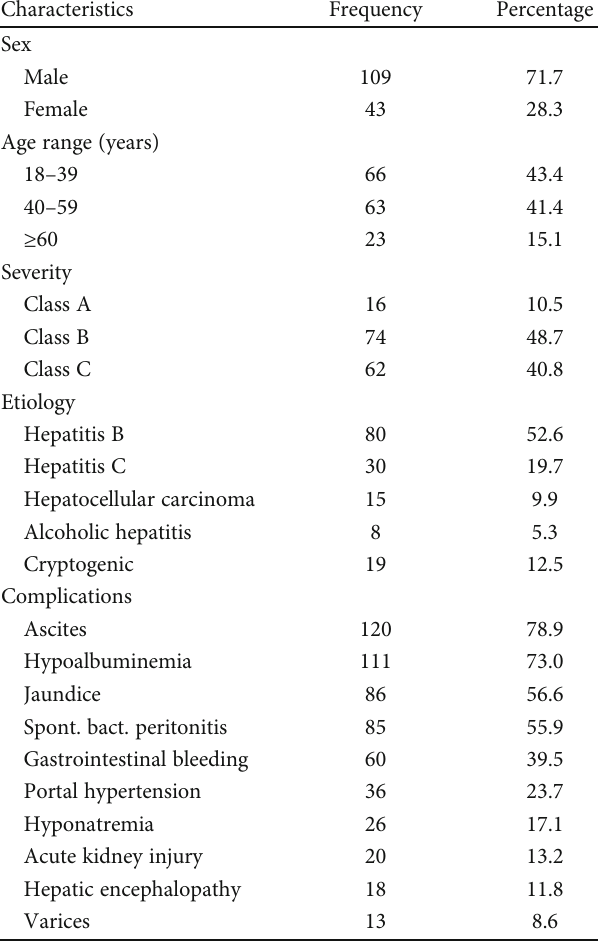
Table 1: Characteristic of patients involved in the study ( n = 152 ). Characteristics